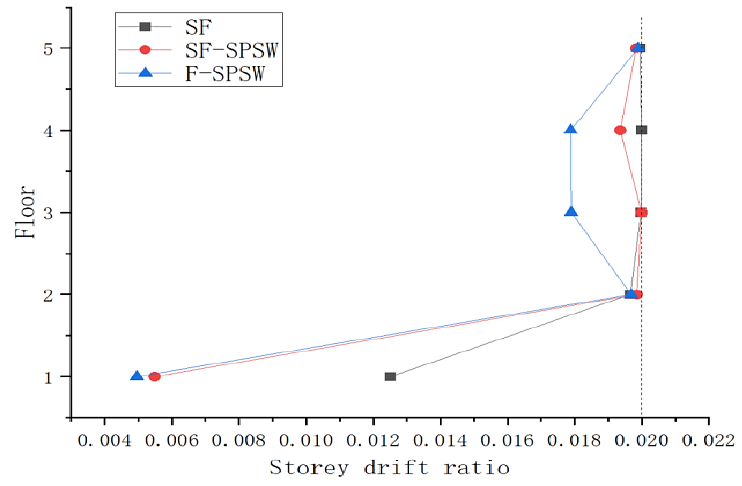
Figure 11. Story drift ratio of SF-SPSW and SF.